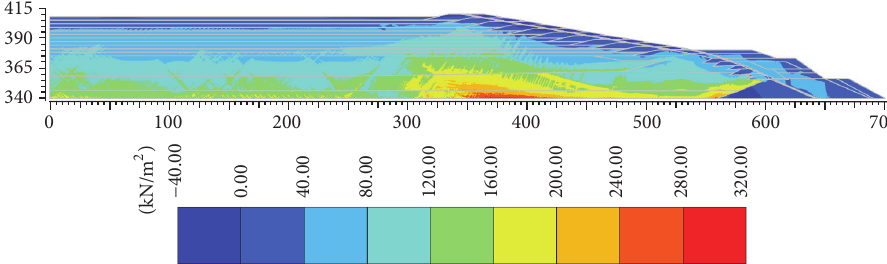
Figure 13: Excess pore pressures after the dam is shaken with extreme earthquake. Negative sign indicates suction.